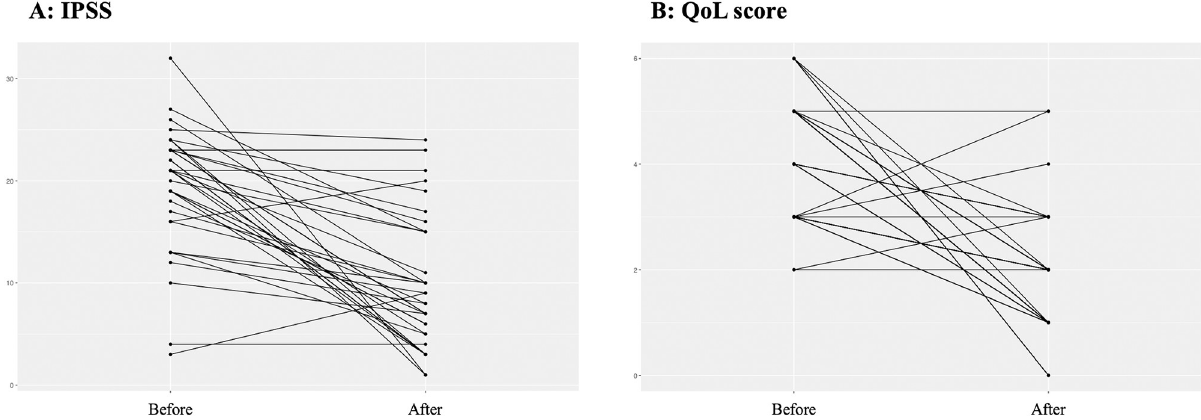
Fig 1. (A) International Prostate Symptom Score (IPSS) before and after treatment (p < 0.001, n = 35). (B) Quality of Life (QoL) score before and after treatment (p < 0.001, n = 35).